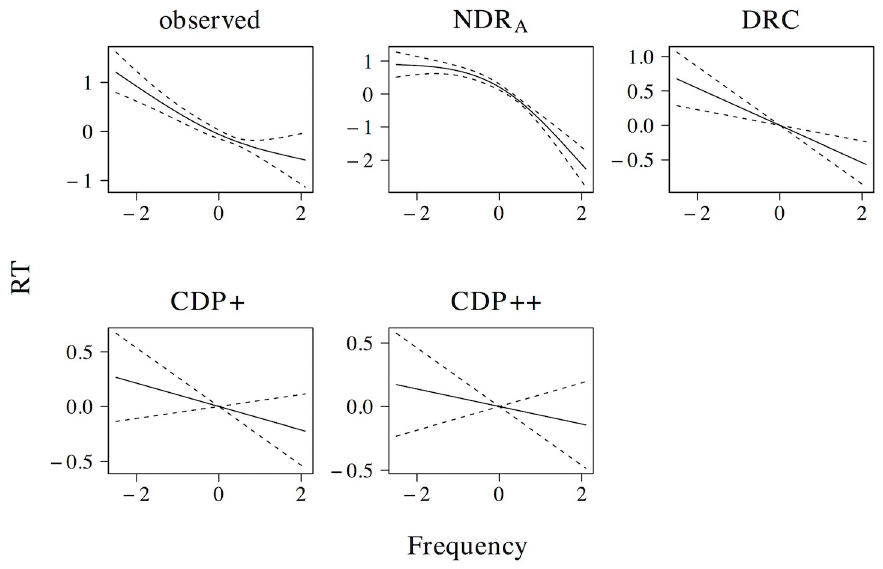
Fig 25. Frequency: Non-words. The effect of frequency in non-word naming. r = 0.131; DRC : r = 0.107; CDP +: r = 0.078; CDP ++: r = 0.087). One potential explanation for the